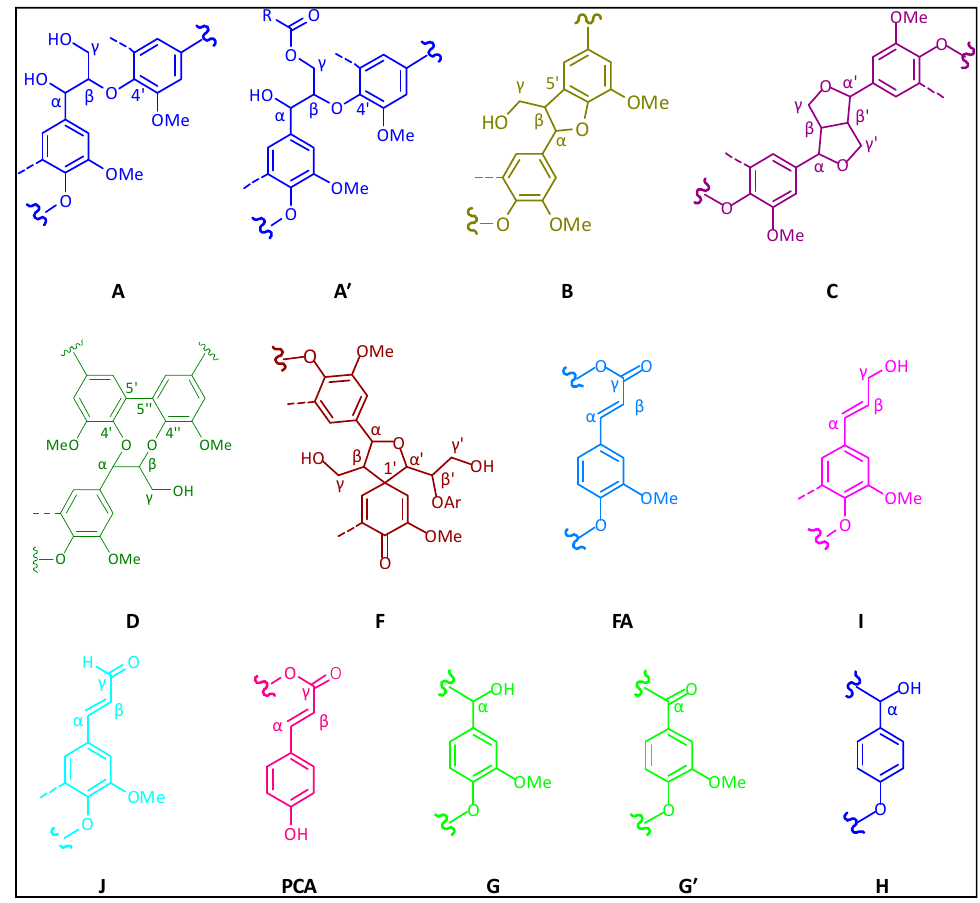
Figure 4. Main substructures in MWL ML and MWL FZ : ( A ) β -O-4 ′ linkages with a free –OH at the γ -carbon; ( A ′ ) β -O-4 ′ linkages with acetylated and/or p -hydroxybenzoated –OH at the γ -carbon; ( B ) phenylcoumaran substructures formed by β -5 ′ and α -O-4 ′ linkages; ( C ) resinol substructures formed by β - β ′ , α -O- γ ′ , and γ -O- α ′ linkages; ( D ) dibenzodioxocin substructures formed by β -O-4 ′ and α -O-4 ′ linkages; ( F ) spirodienone substructures formed by β -1 ′ and α -O- α ′ linkages; ( FA ) ferulate substructures; ( I ) cinnamyl alcohol end-groups; ( J ) cinnamyl aldehyde end-groups; ( PCA ) p -coumarate substructures; ( G ) guaiacyl units; ( G ′ ) oxidized guaiacyl units with a α -ketone; ( H ) p -hydroxyphenyl units.